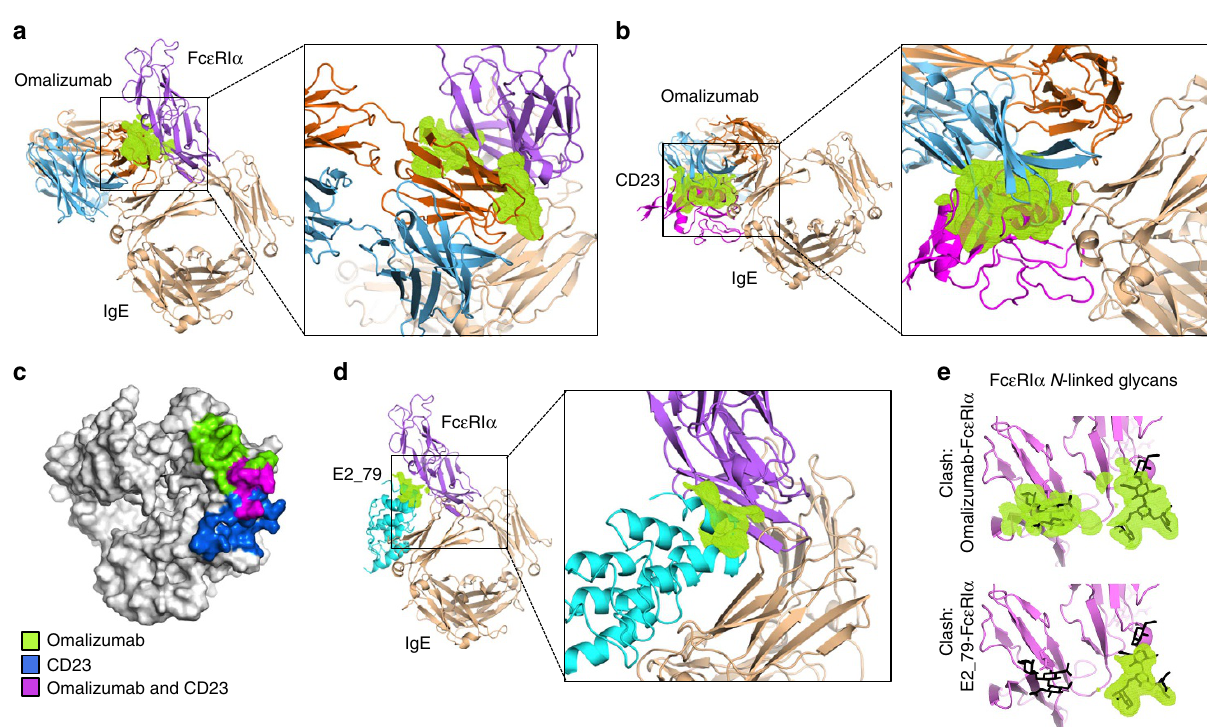
Figure 4 | The structural basis of omalizumab Fc e RI a and CD23 competition. ( a ) Structural alignment of complexes reveals that atomic overlap (green) between the omalizumab light chain (orange) and Fc e RI a (purple) would allow omalizumab to block IgE binding at site 2. ( b ) Steric conflicts (green) between the omalizumab–Fab heavy chain (blue) and CD23 (magenta) as well as direct competition for binding sites ( c ) appear to drive omalizumab inhibition of CD23:IgE interactions. ( d ) The disruptive DARPin inhibitor E2_79 (cyan) has a similar binding mode to the omalizumab Fab, yet has less atomic overlap with Fc e RI a in aligned structures of the complexes. ( e ) The majority of steric clashes (green) between omalizumab and Fc e RI a and E2_79 and Fc e RI a occur with N -linked glycans (black) found on Fc e RI a